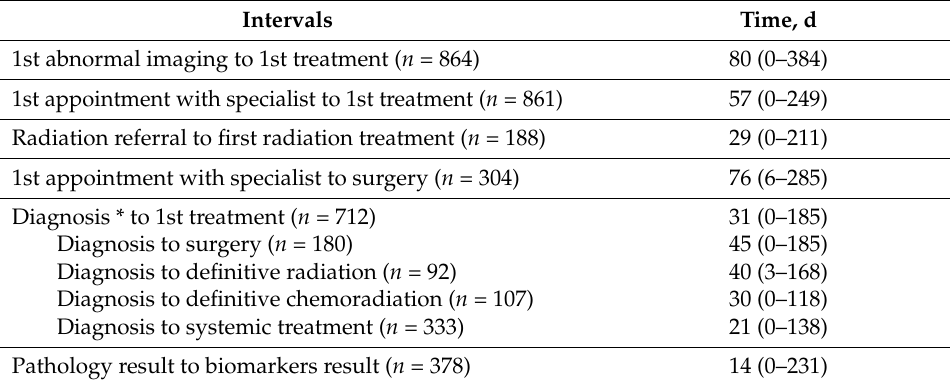
Table 2. Wait times for investigation and